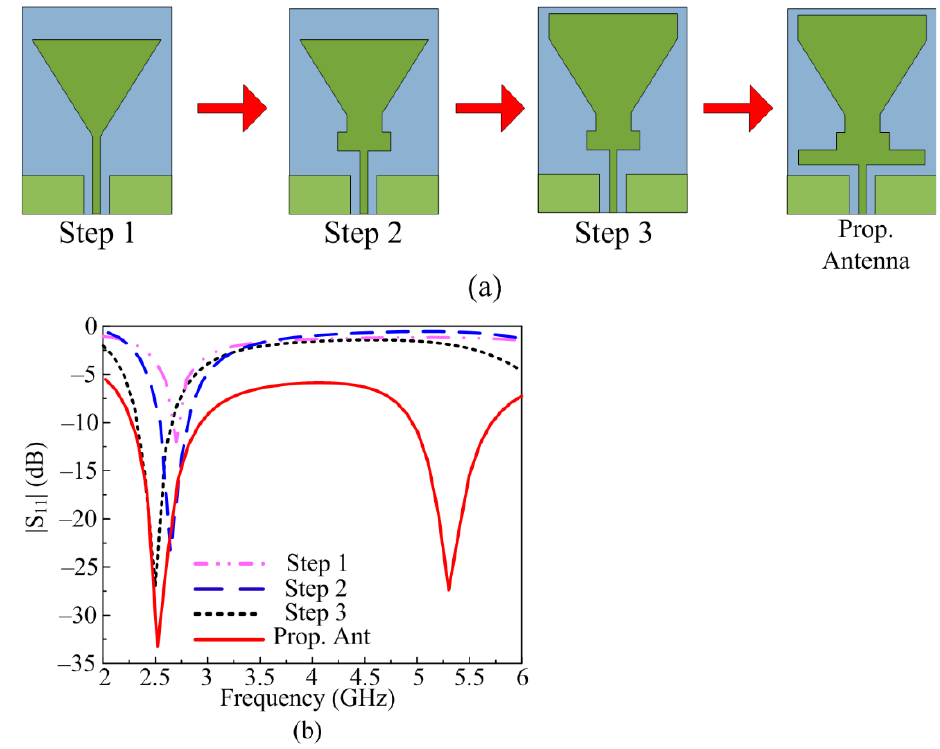
Figure 2. Design stages of the proposed antenna and its impact on the S-parameter. ( a ) The proposed dual-band antenna is obtained after carrying out various design steps. ( b ) The corresponding S-parameter results for each design stage.